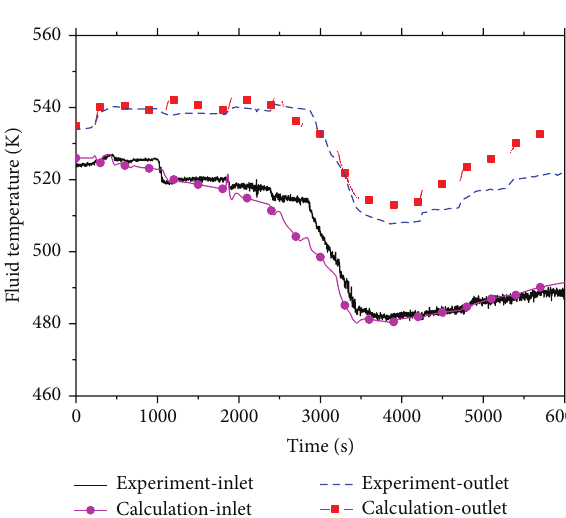
Figure 5: Feedwater mass flow rate for each step.